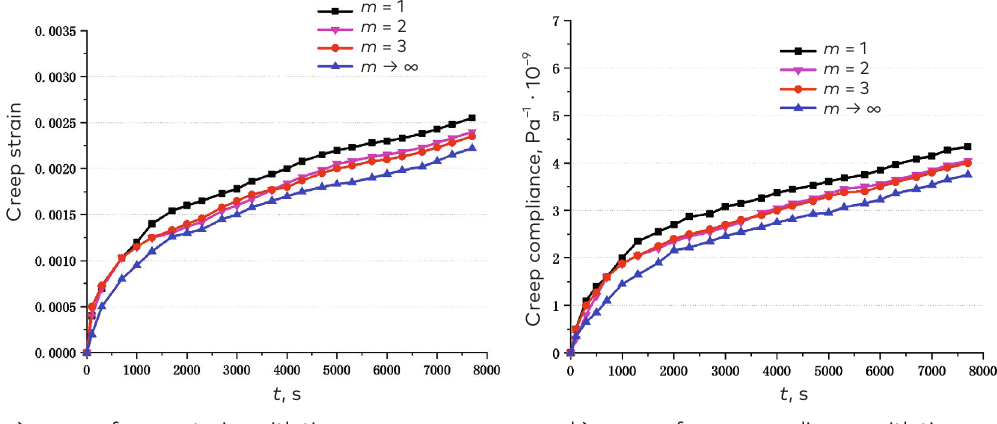
Figure 15. Effects of asphalt mortar heterogeneity on creep behaviours of asphalt